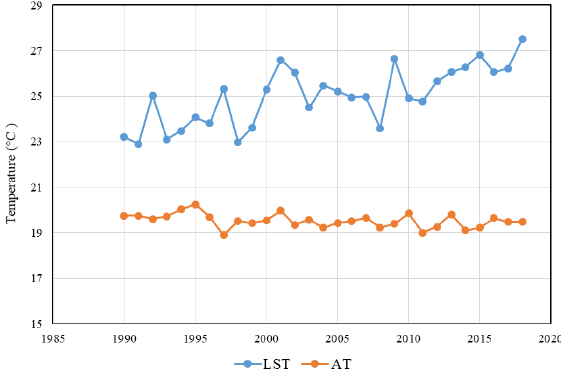
Table 7. Correlation between temperature and built-up extent